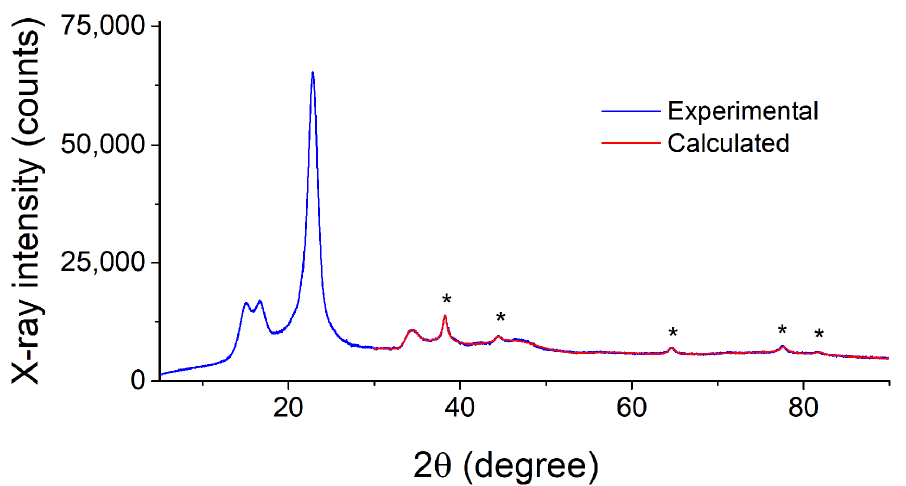
Figure 9. PXRD pattern of the Ag NPs/cotton composite and its fit, evidencing the presence of Ag nanoparticles. The reflections of metallic silver are marked by asterisks.